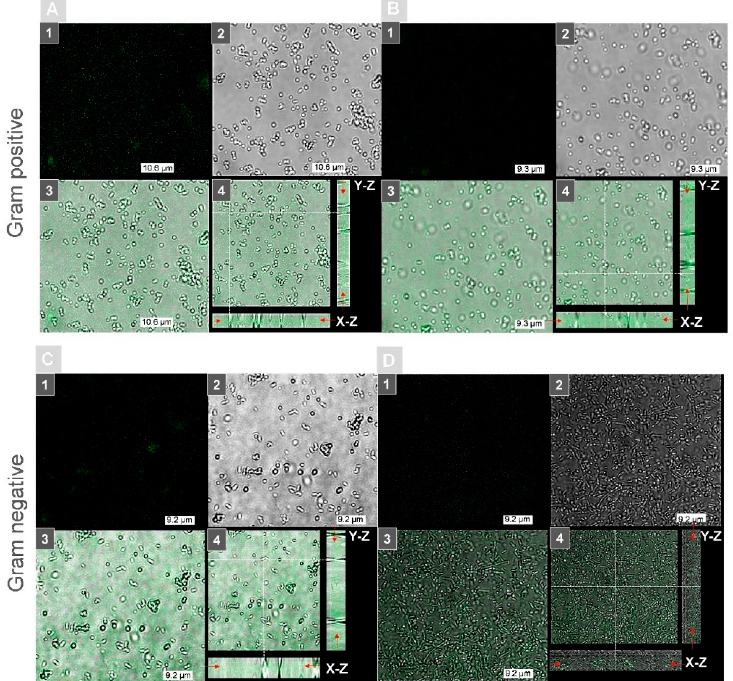
Figure 7. Examination of the Ph localization end encapsulation inside the R 20 silica coating that was performed by fluorescence confocal microscopy for ( A ) S. aureus , ( B ) S. epidermidis , ( C ) P. aeruginosa , and ( D ) E. coli bacteria cells that were cultivated on Ph-doped photoactive coatings: (1) fluorescence image (excitation wavelength: 405 nm), (2) DIC image, (3) combined fluorescence-DIC images, and (4) the combined fluorescence-DIC images with axial cross sections: X-Z/Y-Z (the dashed white lines indicate the cross section through a single cell).